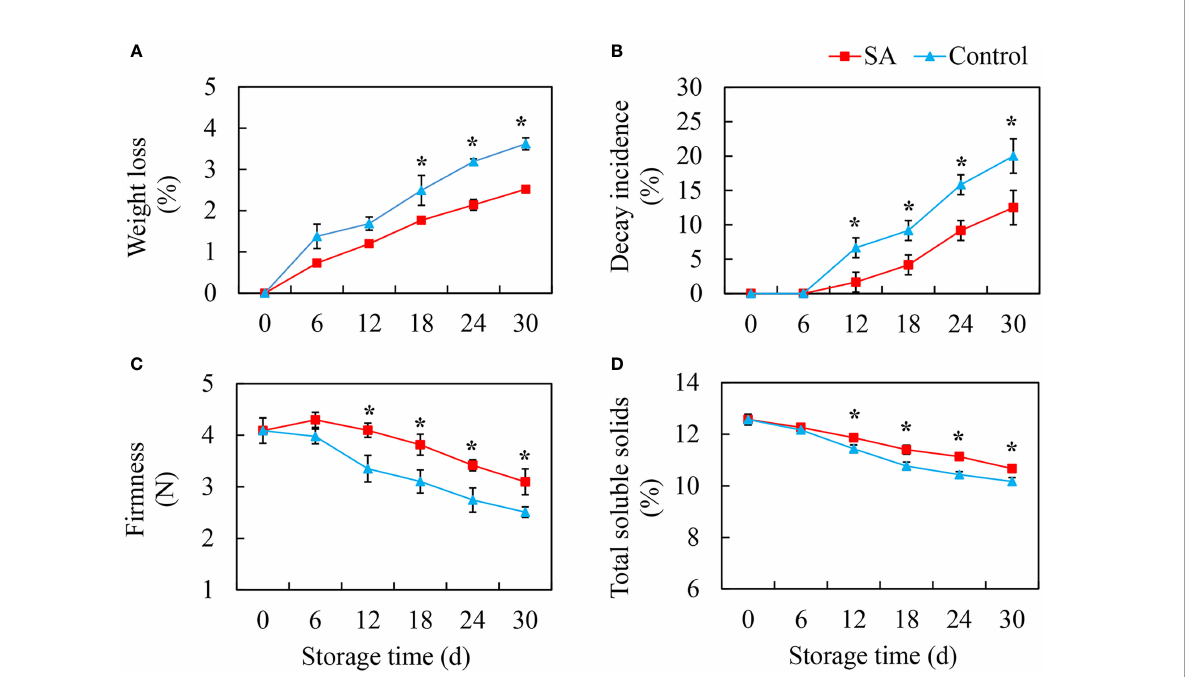
FIGURE 1 Effects of Salicylic acid treatment on fruit quality of blueberry during cold storage. (A) , Weight loss; (B) , Decay incidence; (C) , Firmness; (D) , Total soluble solids (TSS). Error bars represent the standard deviations of the means (n=3). The asterisks show a signi fi cant difference between SA- treated and control fruit ( P <